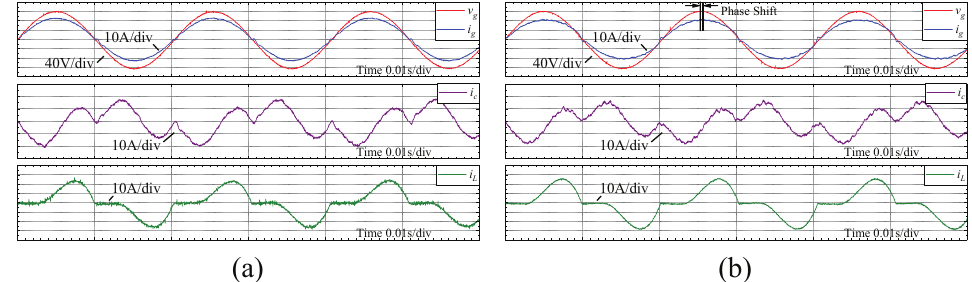
Figure 15. The current waveform at 51 Hz when different controllers are used. ( a ) the proposed RC. ( b ) CRC.